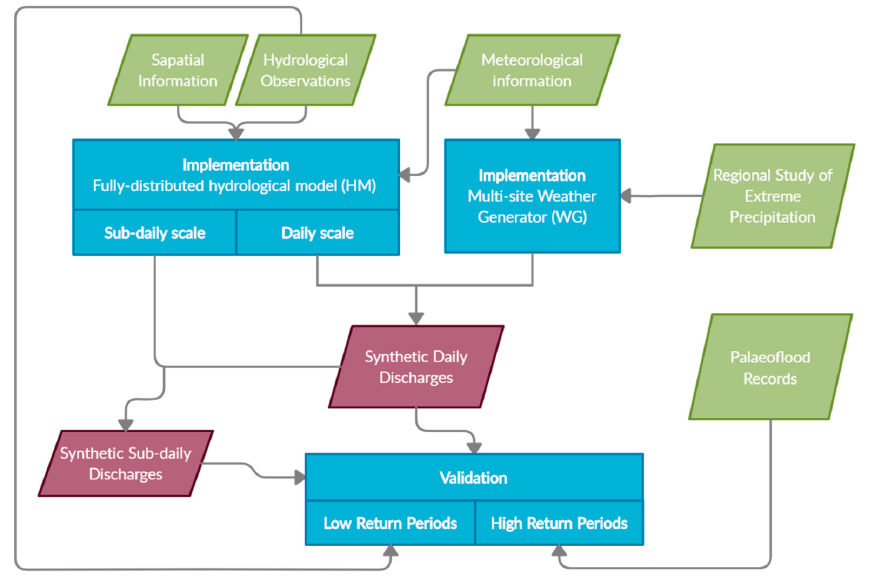
Figure 3. Workflow diagram of the methodology.